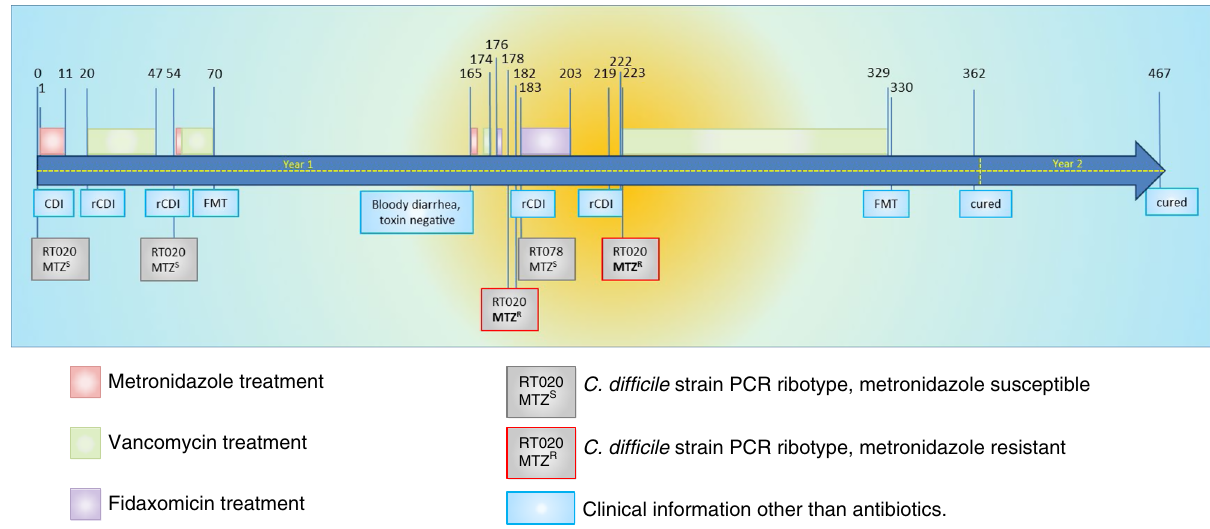
Fig. 1 Timeline of the course of the antibiotic treatment and rCDI in the patient. Dates and timepoints on which treatment was initiated or stopped and C. dif fi cile isolates were recovered are indicated above the timeline. (r)CDI was diagnosed when both a toxin enzyme-immune assay and nucleic acid ampli fi cation test were positive for C. dif fi cile in combination with a physician ’ s assessment of symptoms consistent with CDI. Yellow highlighting indicates the time where pCD-METRO-positive MTZ R C. dif fi cile was isolated. Source data are provided as a Source Data fi